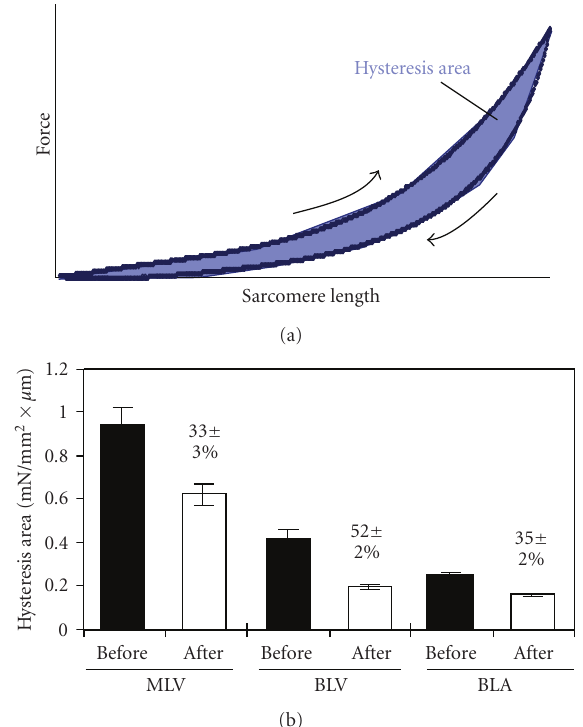
Figure 5: Example experiment addressing e ff ect of calcium and S100A1 on tension in skinned muscle during stretch. (a) Skinned MLV muscle was stretched (0.1 length/sec) in pCa 9.0 (black), pCa 6.8 (red), and pCa 9.0 plus S100A1 solution (blue). Calcium (pCa 6.8) or S100A1 alone did not a ff ect tension during stretch. (b) Skinned MLV muscle was stretched (0.1 length/sec) in pCa 9.0 (black), pCa 6.8 (red squares), and pCa 6.8 plus S100A1 solution (red triangles). Only when calcium (pCa 6.8) and S100A1 are both present is passive tension